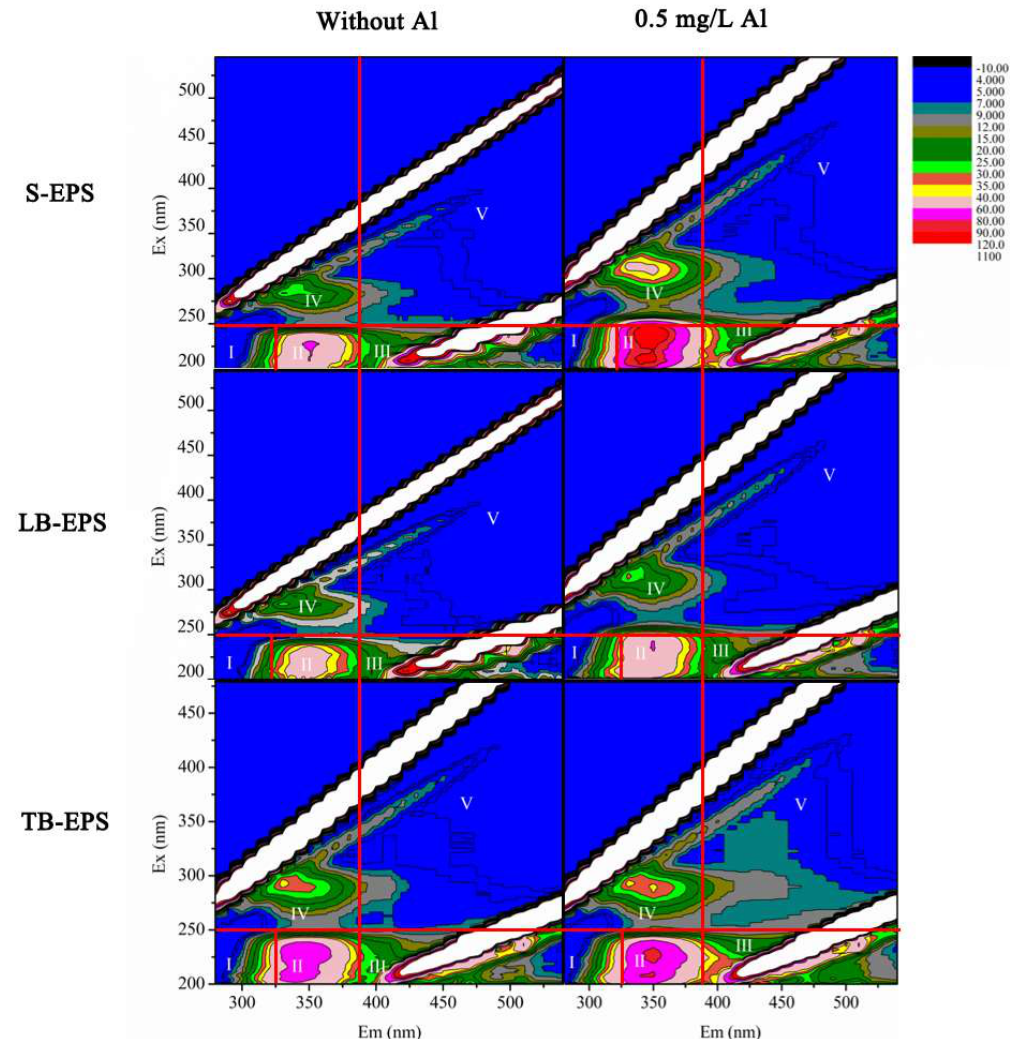
Figure 3. Excitation-emission matrix EEM fluorescence spectra of EPS extracted from the biofilm by cultured 0 mg / L Al (left: S-EPS, LB-EPS, TB-EPS) and cultured by 0.5 mg / L Al (right: S-EPS, LB-EPS, TB-EPS). Five regions were classified according to the methods of Chen (2003) [25] as follows. Region I denotes the tyrosine / tryptophan amino acid region with Ex / Em = 220–250 / 280–320, region II denotes the tyrosine / tryptophan protein region with Ex / Em = 220–250 / 320–380, region III denotes the fulvic acid region with Ex / Em = 220–250 / 380–460, region IV denotes the tryptophan-like or soluble